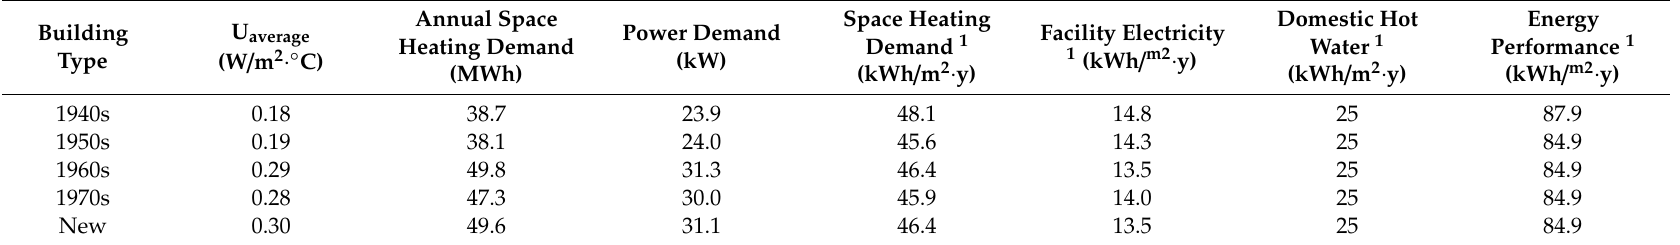
Table 18. Average U-value of the building envelope needed in order to achieve the required energy performance for the newly constructed buildings heated with district heating in central Sweden.